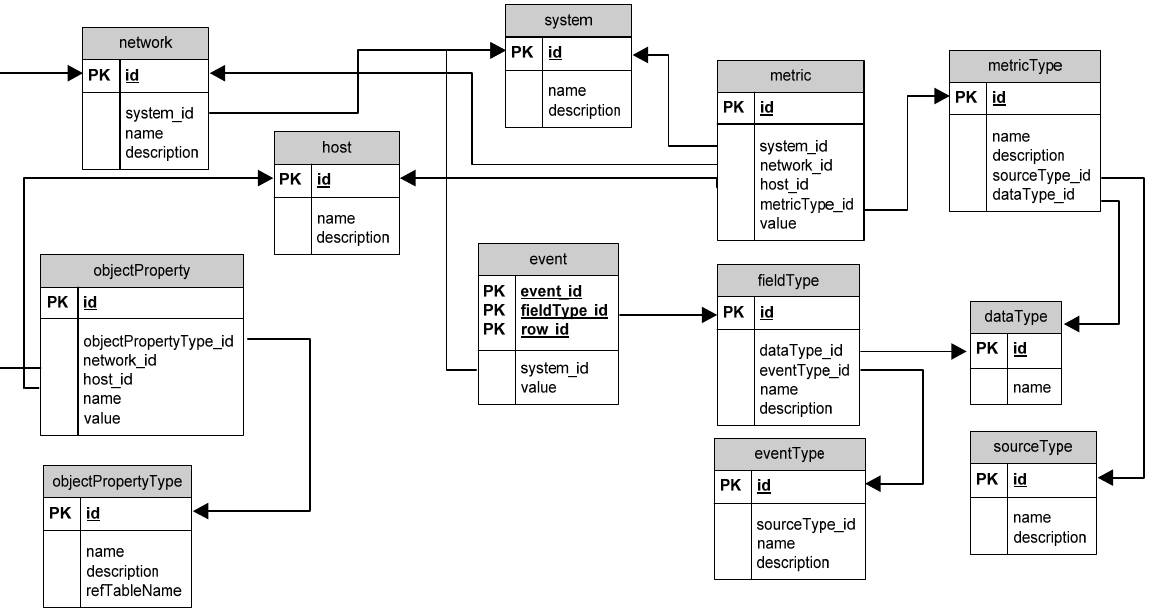
Figure 6. Relational part of Attack Modeling and Security Evaluation Component (AMSEC) repository data